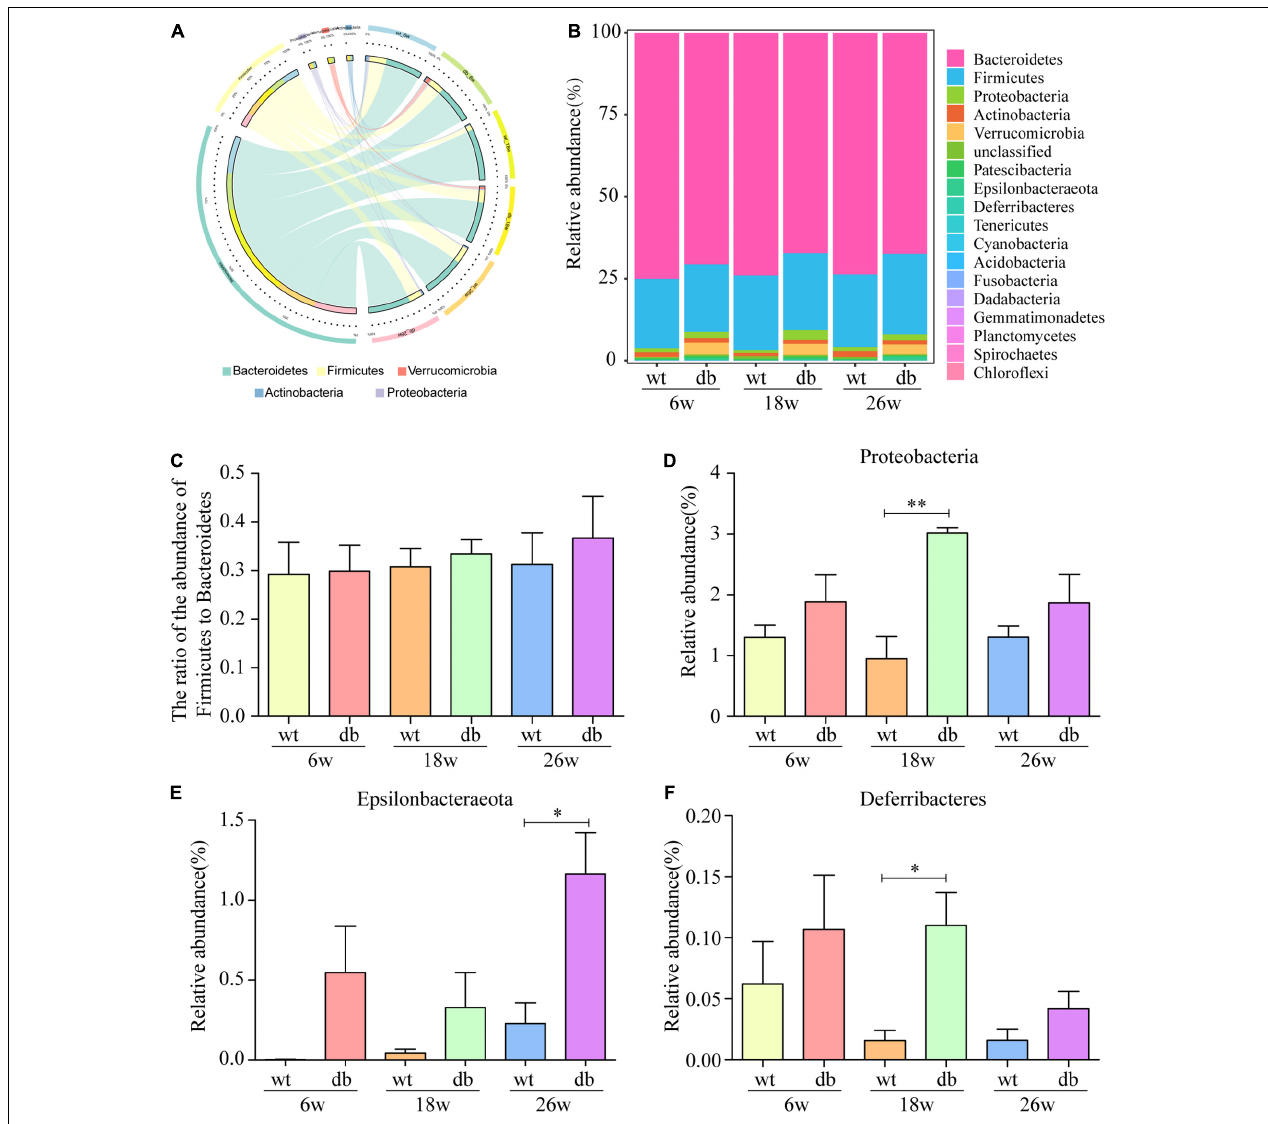
FIGURE 6 | Alteration of gut microbiota composition in db/db mice at the phylum level. (A,B) The Circos and bar chart of common bacterial communities in each group. (C) The ratio of the abundance of Firmicutes to Bacteroidetes in each group. (D–F) The relative abundance of three bacterial communities in each group. ( n = 6 per group); ∗ P < 0.05; ∗∗ P <